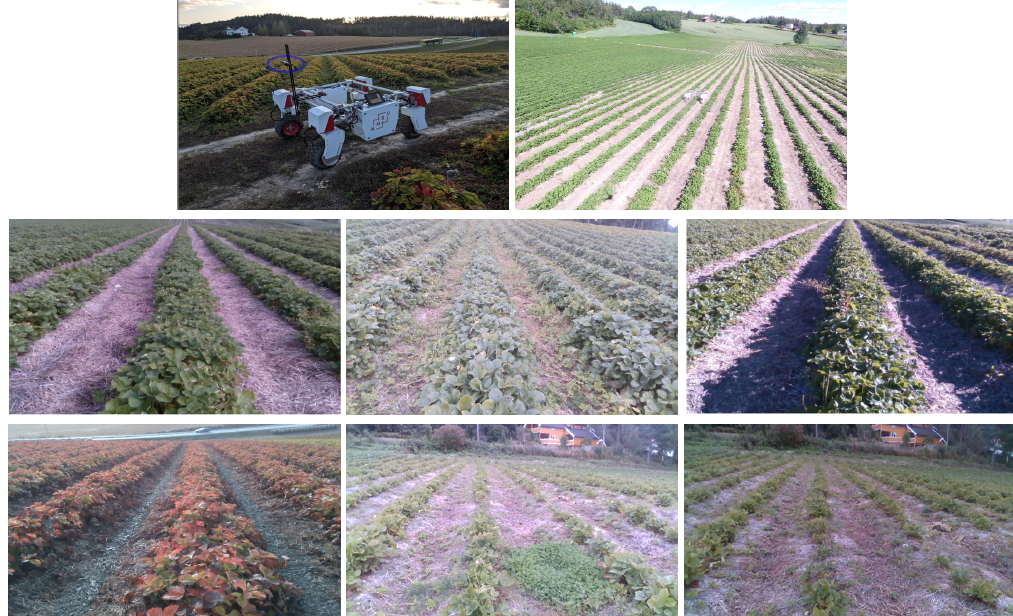
Figure 1. Top: The Sensors mounted on the “Thorvald” Robot Platform for dataset collection on hilly terrains. The variation of crop rows from the strawberry fields in Norway have illustrated from the RGB images listed above. Second Row: The transition of plant growth from July to September in 2019 defines the illumination problems in which the plants or shadow covers the entire driveable areas. Third Row: presents the change in color of the plants throughout the season and showcase the problem of random plants growing over lanes or the occurrence of bare patches along with the